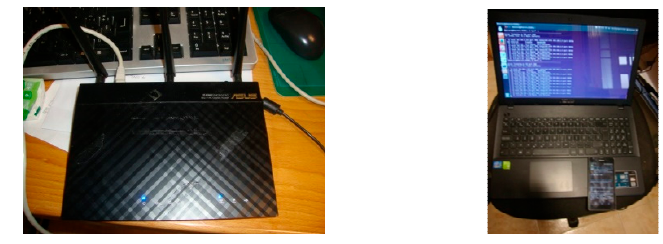
Figure 19. Main additional devices which generated interfering traffic.